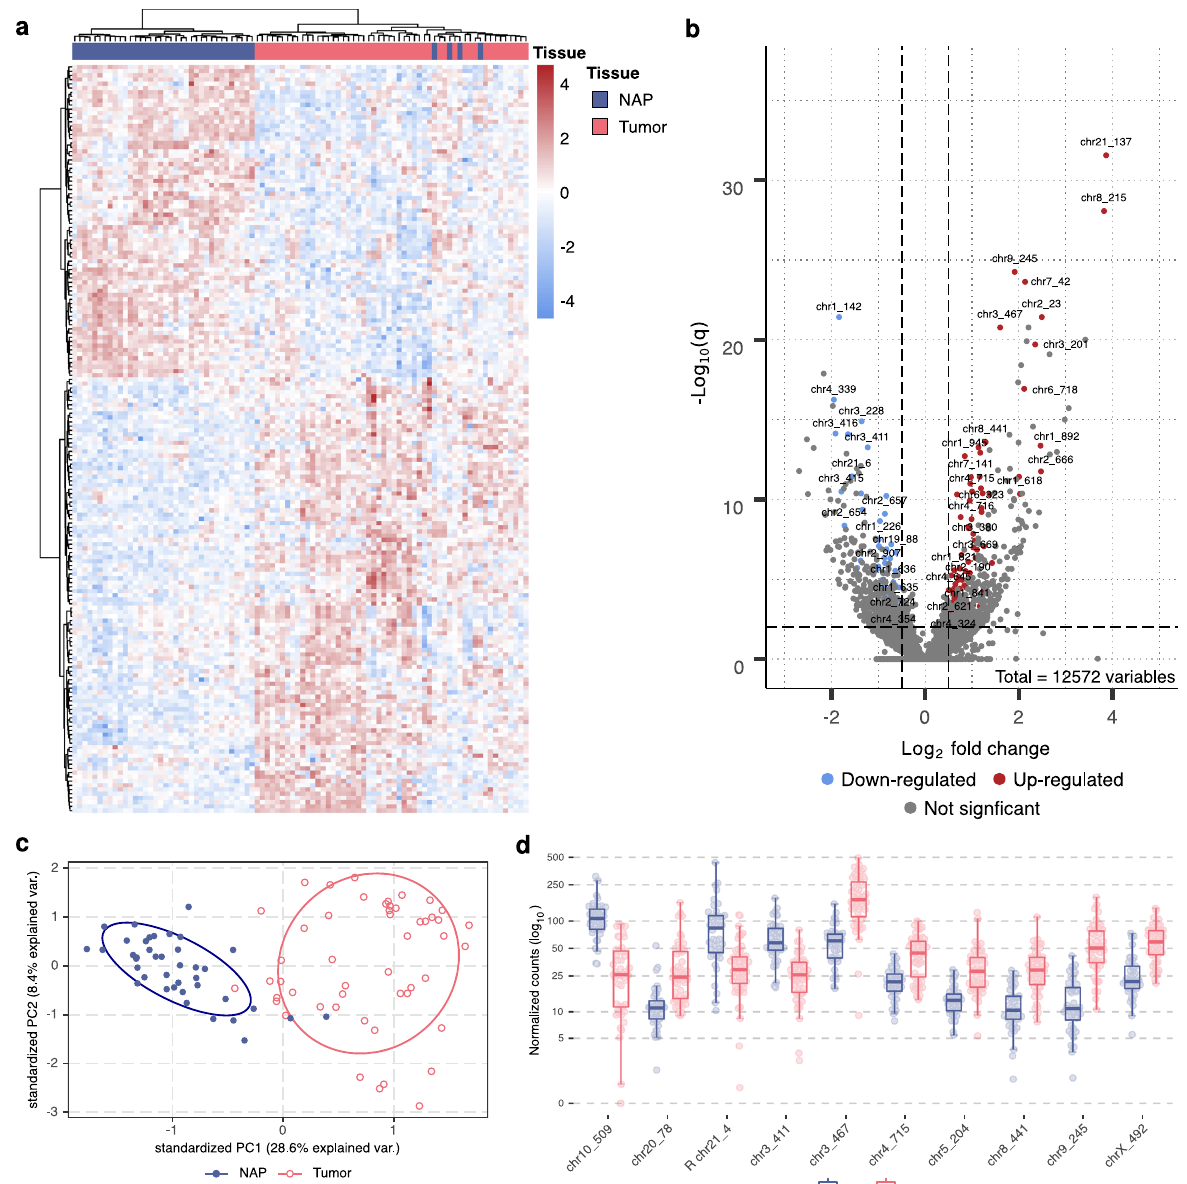
Fig. 5 Prostate cancer-speci fi c expression of the hCRISPRs in the NGS-ProToCol dataset. a Unsupervised clustering (Euclidean distances; Ward.D2) of malignant (orange; top-bar) and healthy (blue; top-bar) prostate tissues using normalized read counts (VST) as Z-scores over all 177 statistically signi fi cant hCRISPRs. (|log 2 fold-change | ≥ 0.5, average read-count over all samples ≥ 10, and q ≤ 0.05). Negative Z-scores are highlighted in green whilst positive Z-scores are highlighted in red. b Volcano-plot depicting the log 2 fold-change ( x -axis) and adjusted p -value (q) ( y -axis; in − log 10 scale) of all 12,572 hCRISPRs. The hCRISPRs which were found to be differentially upregulated (log 2 fold-change ≤ 0.5, average read-count over all samples ≥ 10 and q ≤ 0.05) and downregulated (|log ≥ 0.5, average read-count over all samples ≥ 10 and q ≤ 0.05) in cancer are shown by red and blue dots, 2 fold-change | respectively. The hCRISPR identi fi er (#Order) is shown for the top 25 most substantial (based on adjusted p ) upregulated and downregulated hCRISPRs. c Overview of the strati fi cation of the NGS-ProToCol cohort using principal component analysis (PCA) on the 177 differentially expressed hCRISPRs (using VST-normalized read counts) with the fi rst two principal components (PC1 and PC2). Malignant prostate tissues are depicted by salmon points whilst the normal adjacent to tumor prostate tissues are depicted by blue points. d Boxplots representing the normalized expression (VST-transformed read-count) of the top ten hCRISPRs with an absolute log 2 fold-change ≥ 1 and average read counts ≥ 20, ordered on descending q -value; median, Q1 and Q3 are highlighted with a bold black line and error bars, respectively. Malignant prostate tissues are depicted by salmon points whilst the normal adjacent to tumor prostate tissues are depicted by blue points. Normalized expression (VST-transformed read-count; y -axis) is shown in log 10